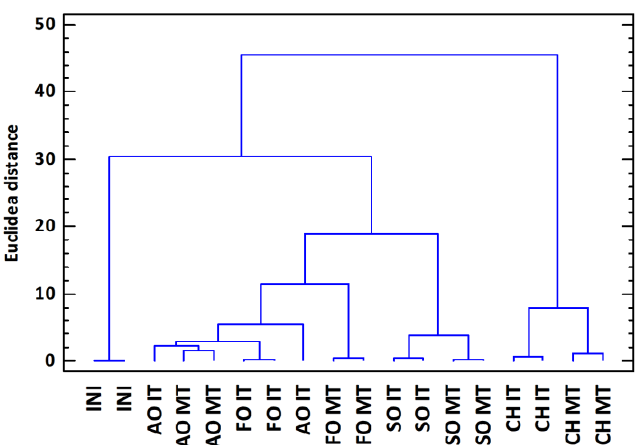
Figure 2. Cluster analysis obtained using the Euclidean distance as metrics and the Ward method as clustering rule for the analyzed samples using as variables the phenolic compounds, the TPI, and the chromatic variables (INI: Initial distillate; AO: American oak; FO: French oak; SO: Spanish oak; CH: Chestnut; IT: Intense toasting level; MT: Medium toasting level).